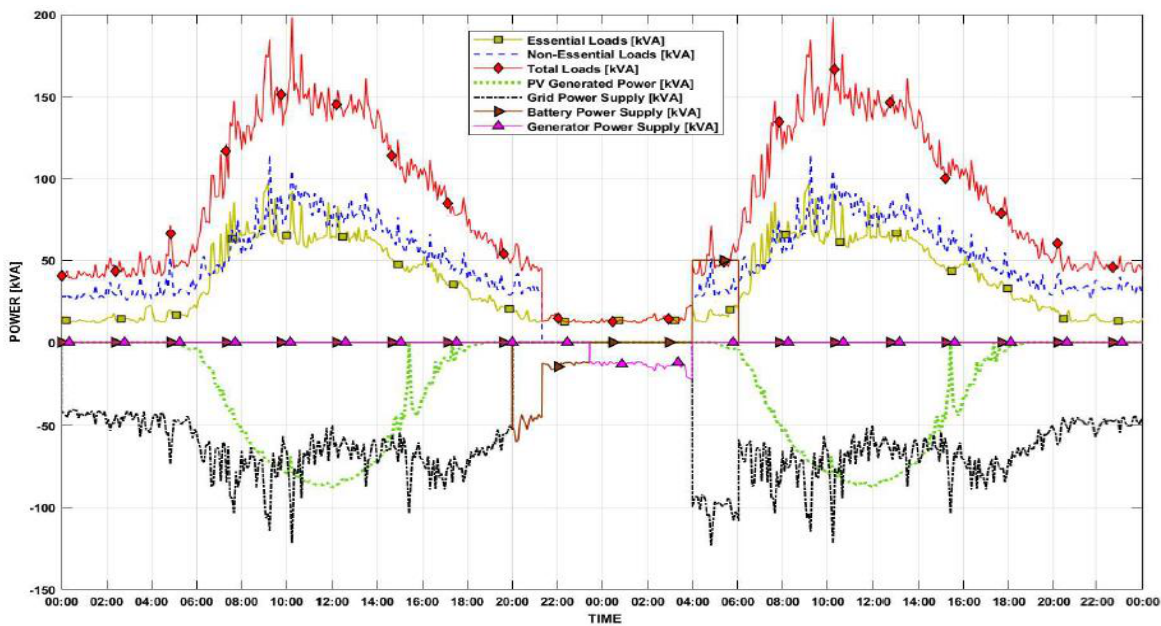
Figure 23. Performance of the optimum-sized energy storage during an 8-h power cut at 12 p.m.